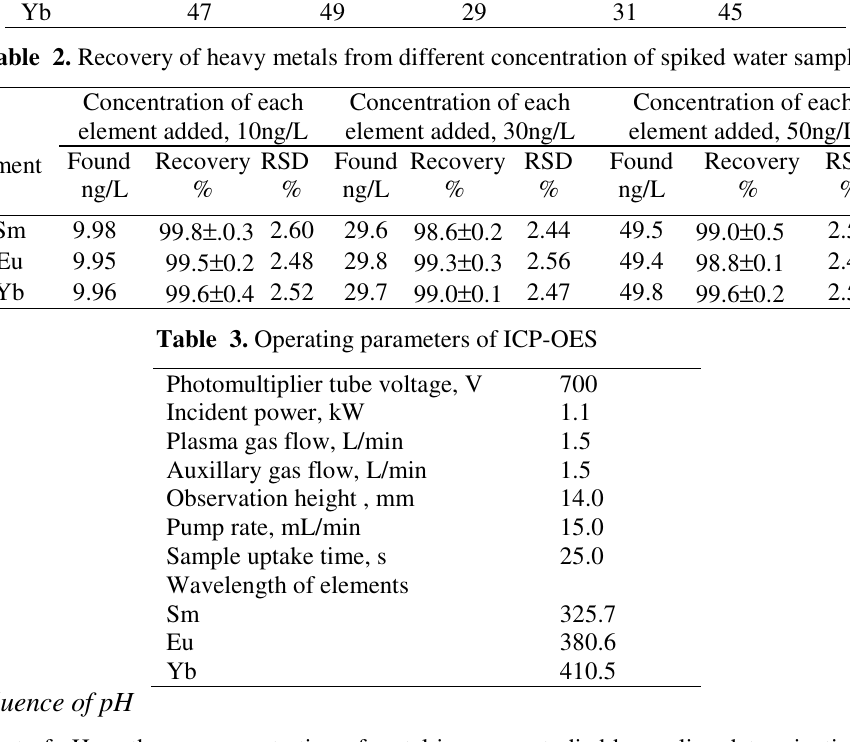
Table 2. Recovery of heavy metals from different concentration of spiked water samples